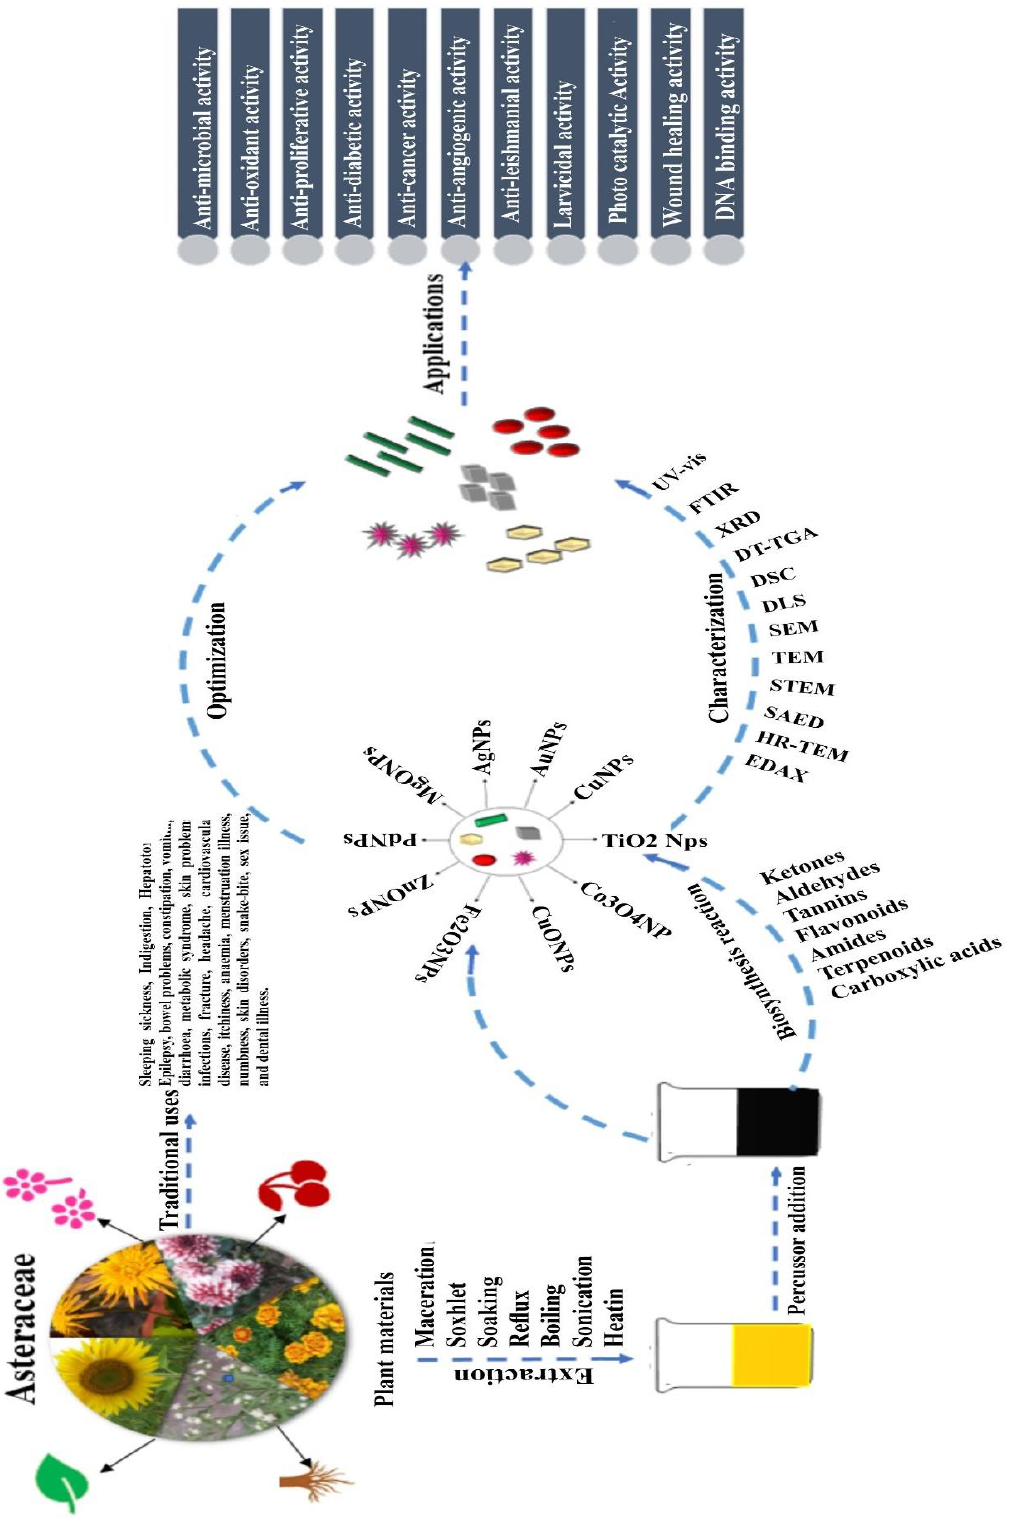
Figure 1. Flow chart showing the steps involved in the extraction, synthesis, optimization, and characterization of nanoparticles from the Asteraceae family and its applications.